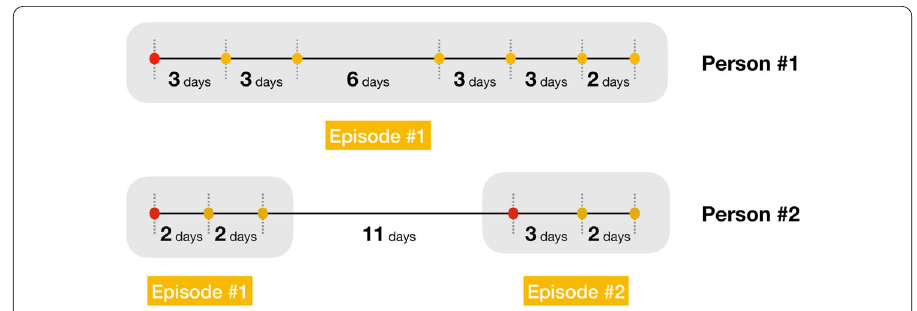
Figure 1 An episode of care. The medical records for influenza within 10 days from the most recent medical record of the same person are bound to a single episode of care. Then, we choose the first medical record of each episode of care, which is marked by a red dot, as an incidence of influenza. Here, yellow dots mean medical records within the same episode of